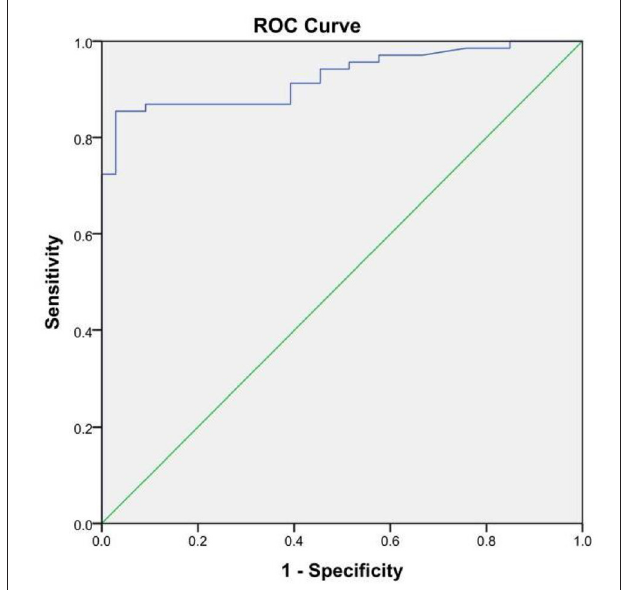
FIGURE 6 | The receiver operating characteristic curve of the indirect ELISA with the SAT method as state variable. The area under the curve (AUC) was 0.926 (95%CI, 0.877–0.975); the standard errors (under the non-parametric assumption) were 0.025, p <